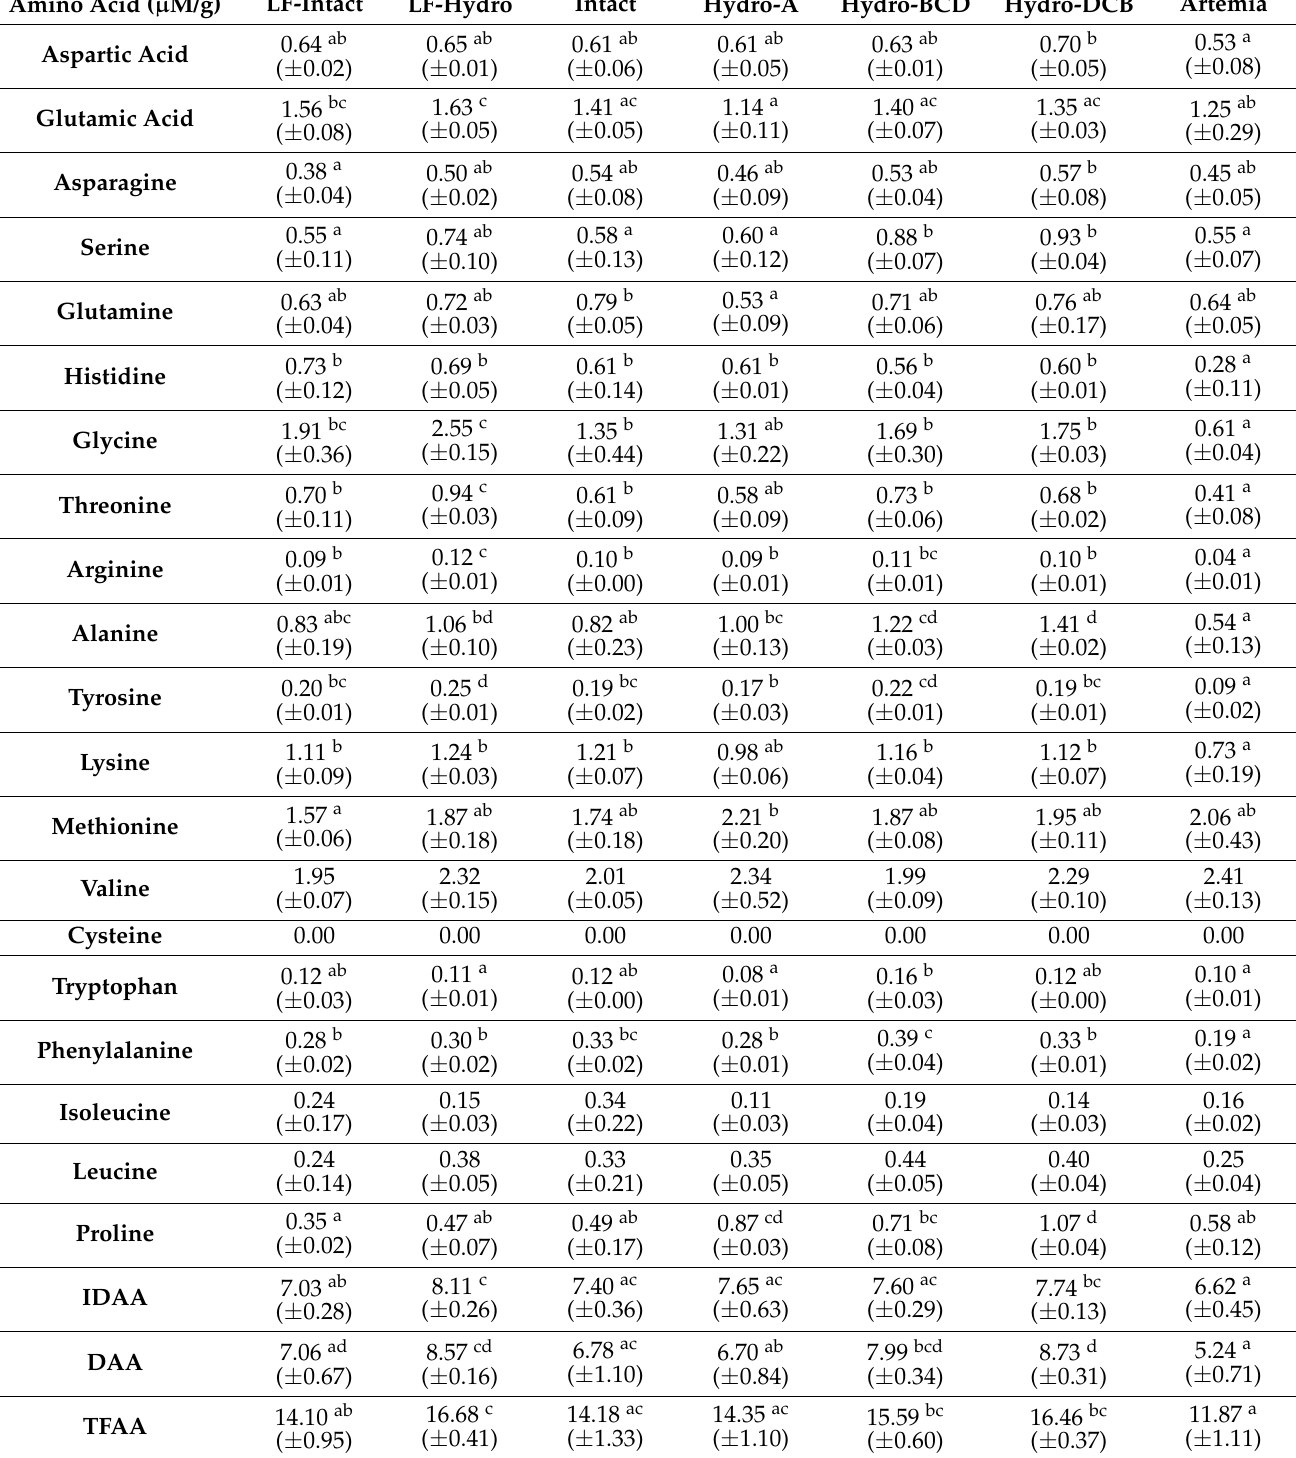
Table 5. Postprandial FAA composition in